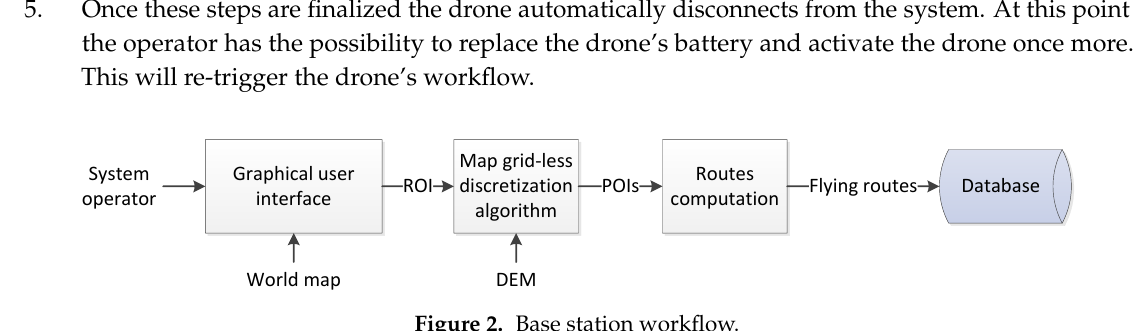
Figure 2. Base station